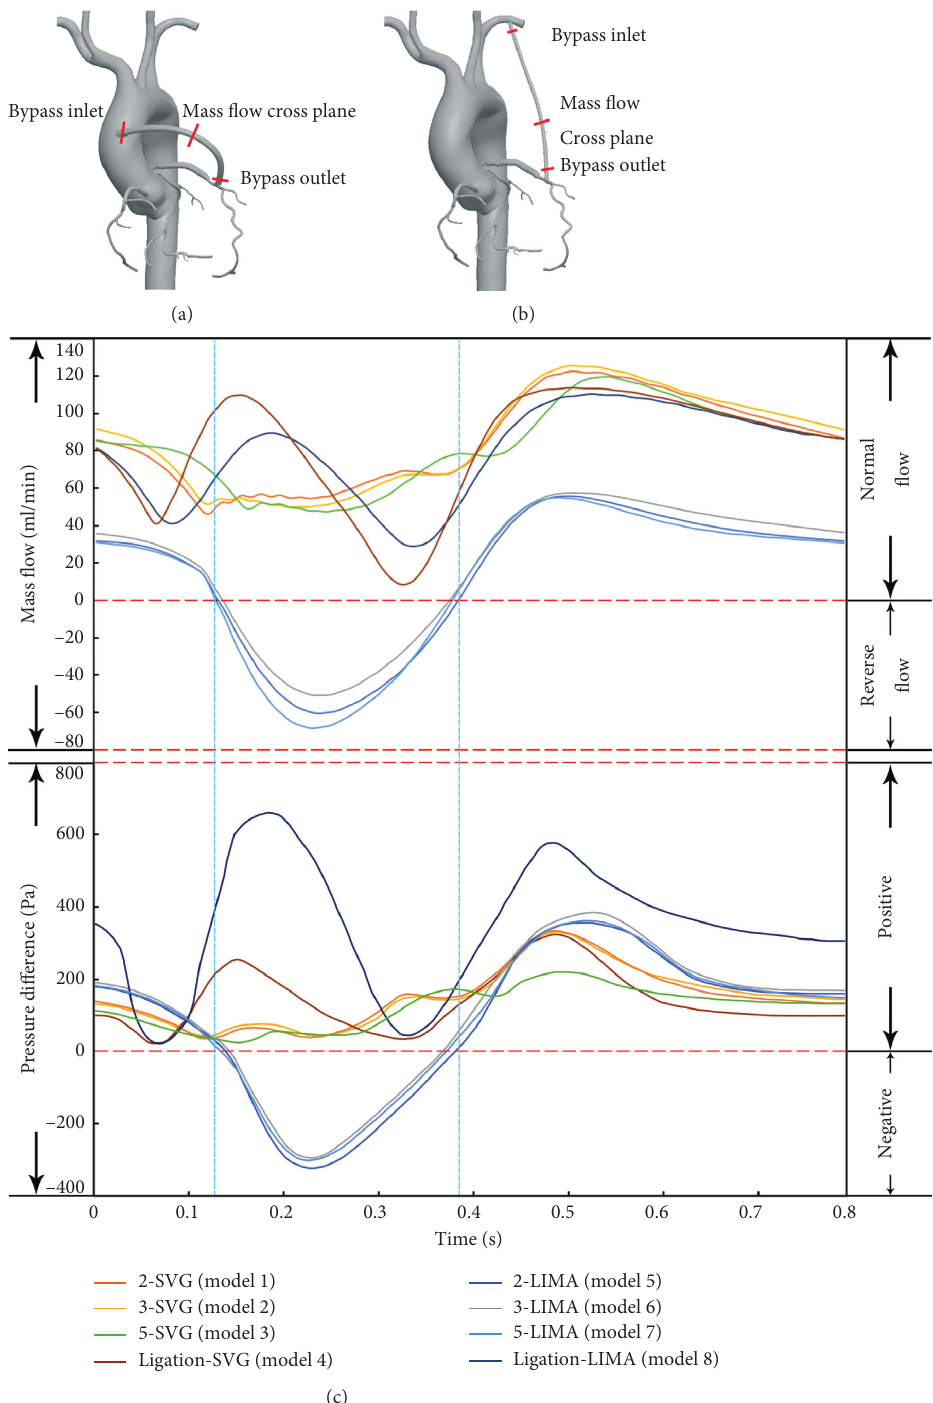
Figure 3: The mass flow rate depending on times of the bypass grafts through the cross plane and the pressure difference between the bypass inlet and the bypass outlet. (a) Representation of the SVG virtual surgery model and three locations on the SVG. (b) Representation of the LIMA virtual surgery model and three locations on the LIMA. (c) The mass flow rate through the cross plane of the bypass grafts in all models, as shown in (a) and (b), and the pressure difference between the bypass inlet and bypass outlet in all models, as shown in (a) and